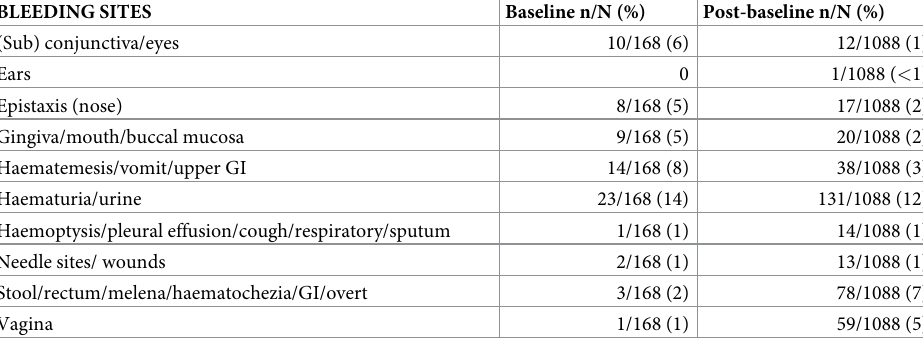
Table 5. Number and percentage of bleeding sites